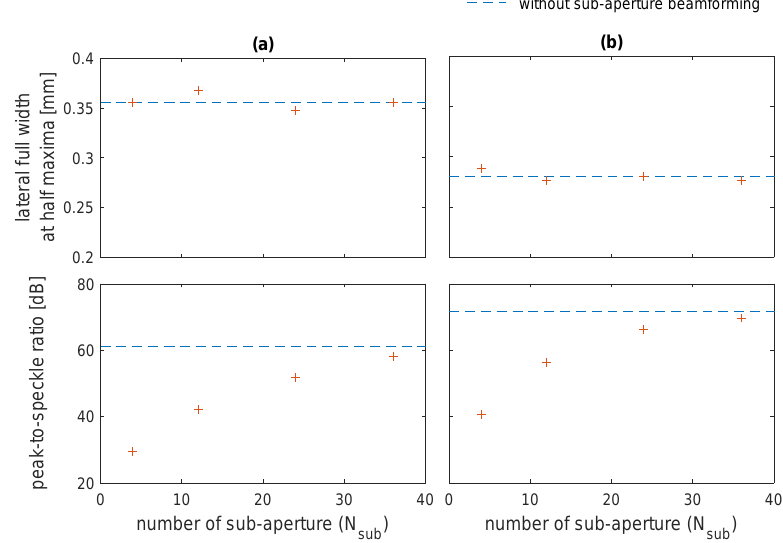
Figure 7. Changes in ( top ) lateral full widths at half maxima and ( bottom ) peak-to-speckle ratio obtained by the proposed method with gPCF estimated before applying the adaptive beamformer weights. Results were obtained with respect to point targets at axial depths of ( a ) 12 mm and ( b ) 22 mm.